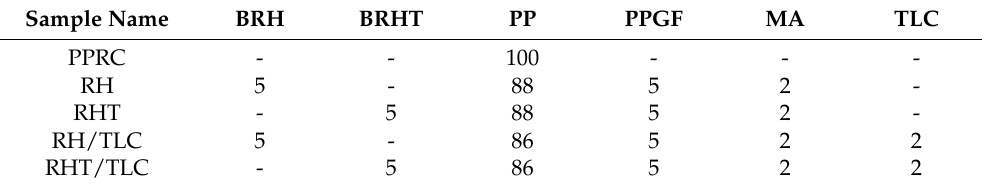
Figure 2. Fabrication of biocomposite ( a ) melt mixing, ( b ) thermal hydraulic compression molding. Table 1. Composition of raw materials for wood polymer biocomposite,